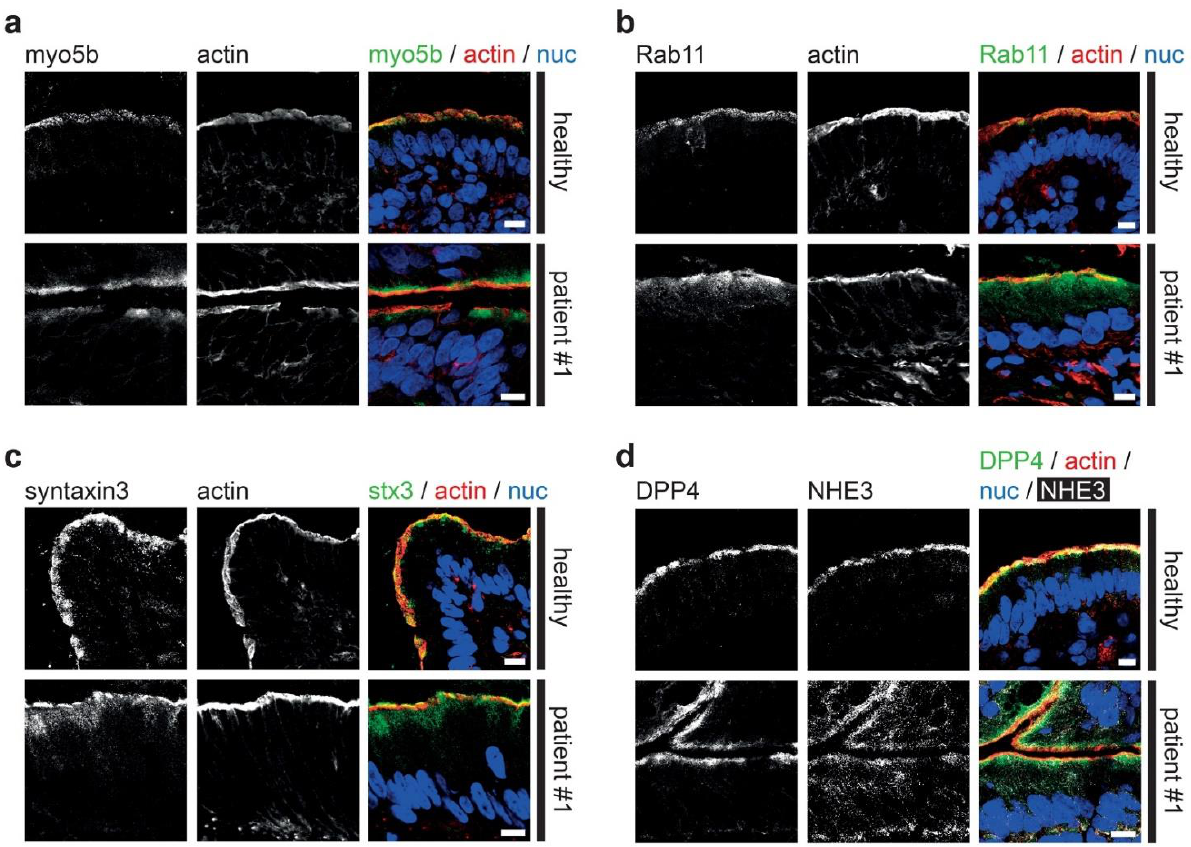
Figure 1. Aberrant localization of apical proteins in MYO5B-PFIC enterocytes. Laser-scanning immuno-fluorescence micrographs of duodenal enterocytes of patient #1 show ( a ) apical and aberrant, subapical localization of mutated myo5b, subapical accumulation of Rab11 ( b ) and syntaxin3 ( c ), as well as cytoplasmic mislocalization of NHE3 ( d ) in comparison to controls. DPP4 localization ( d ) seems unaltered. Brush border microvilli indicated by actin staining; scale bars = 10 µ